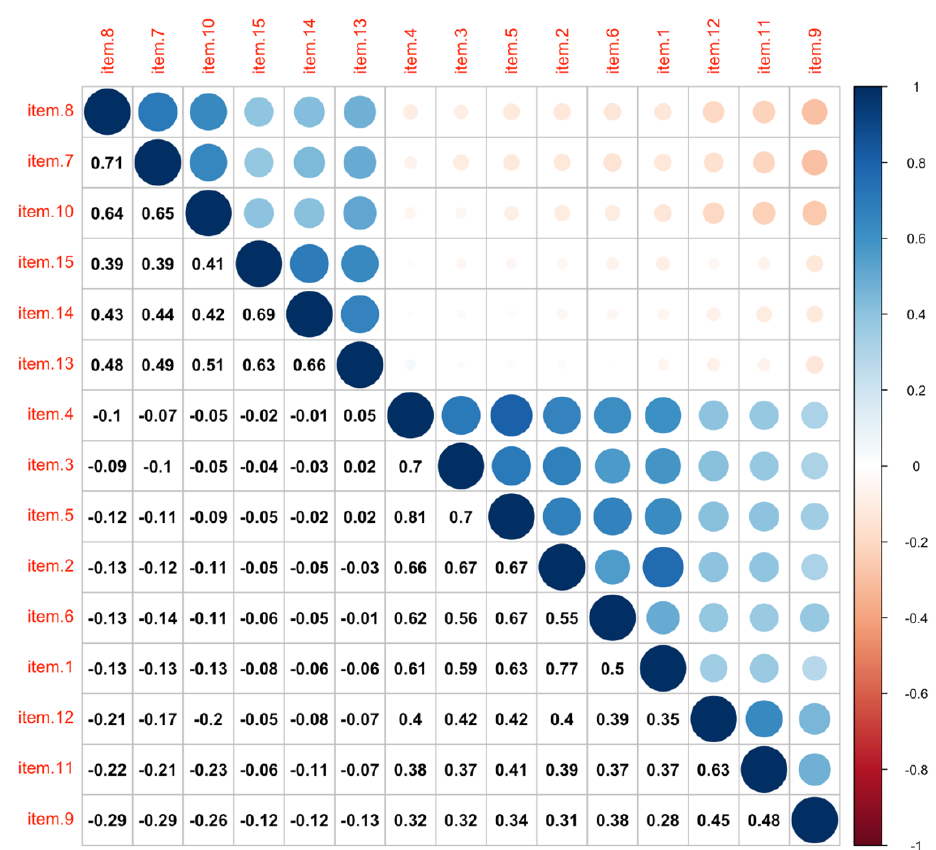
Figure 2. Intercorrelations among INQ Items. ( n = 1805).